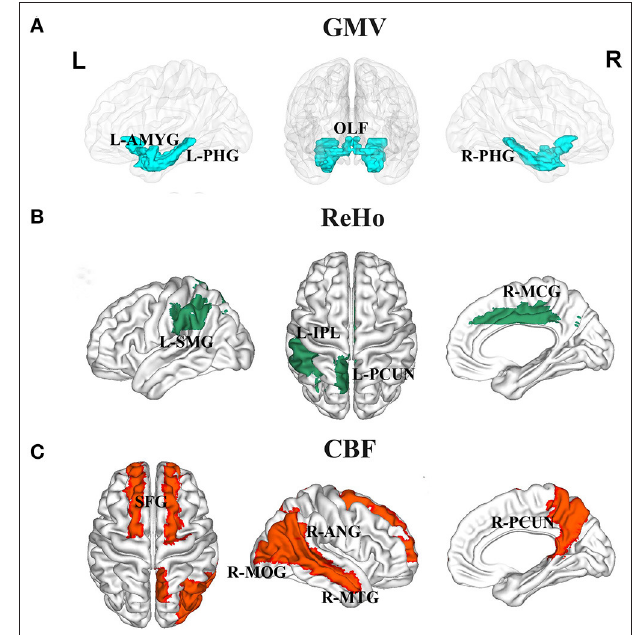
FIGURE 3 | Brain regions associated with serum liver function markers. (A) GMV in the left amygdala, bilateral olfactory cortex, and bilateral parahippocampal gyrus were related to serum protein levels. (B) ReHo in the left inferior parietal lobule, left supramarginal gyrus, left precuneus, and right middle cingulate gyrus were related to serum bilirubin levels. (C) CBF in the bilateral superior frontal gyrus, right middle occipital gyrus, right angular gyrus, right precuneus, and right middle temporal gyrus were related to serum ALT level. Abbreviations: GMV, gray matter volume; ReHo, regional homogeneity; CBF, cerebral blood flow; ALT, alanine transaminase; OLF, olfactory cortex; PHG, parahippocampal; AMYG, amygdala; IPL, inferior parietal lobule; SMG, supramarginal gyrus; PCUN, precuneus; MCG, middle cingulate gyrus; SFG, superior frontal gyrus; MOG, middle occipital gyrus; ANG, angular gyrus; MTG, middle temporal gyrus; L, left; R,